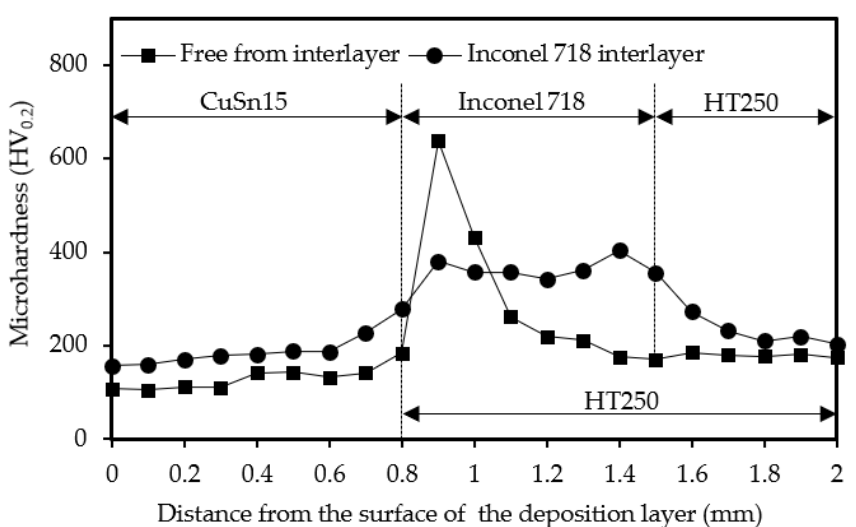
Figure 12. Variations in microhardness along the cross-section of samples with varying interlayers.